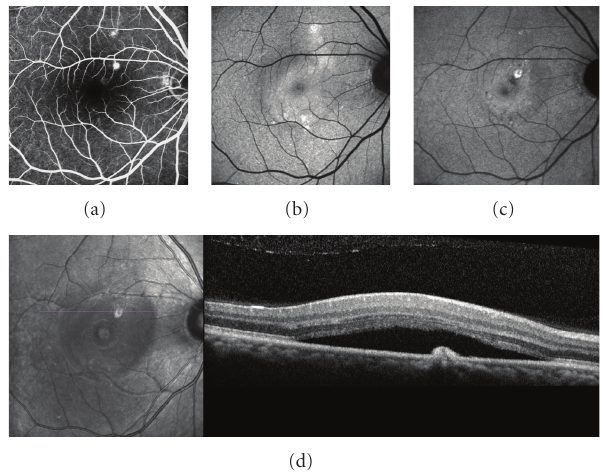
Figure 1: Patient with 12 months of history of CSC in the right eye. (a) Two dots spots of leakage in the angiography; (b) standard FAF, presenting with di ff use hyperFAF; (c) NIA, showing suprafoveal hypofluorescent point surrounded by a ring of hyperAF, corre- sponding exactly with the PEDs in (d); (d) SD-OCT exhibiting the PED and neurosensorial retinal detachment.